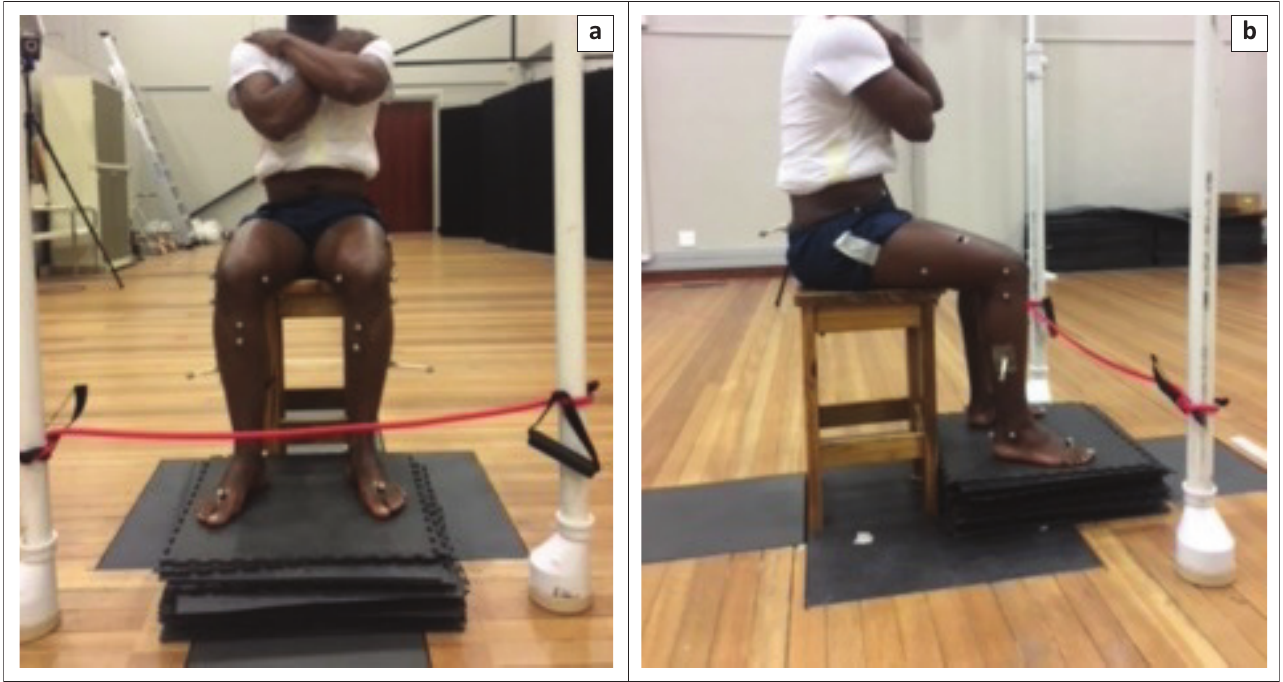
FIGURE 3: Active knee extension in sitting (a) frontal view and (b) lateral view to measure non-weightbearing joint position